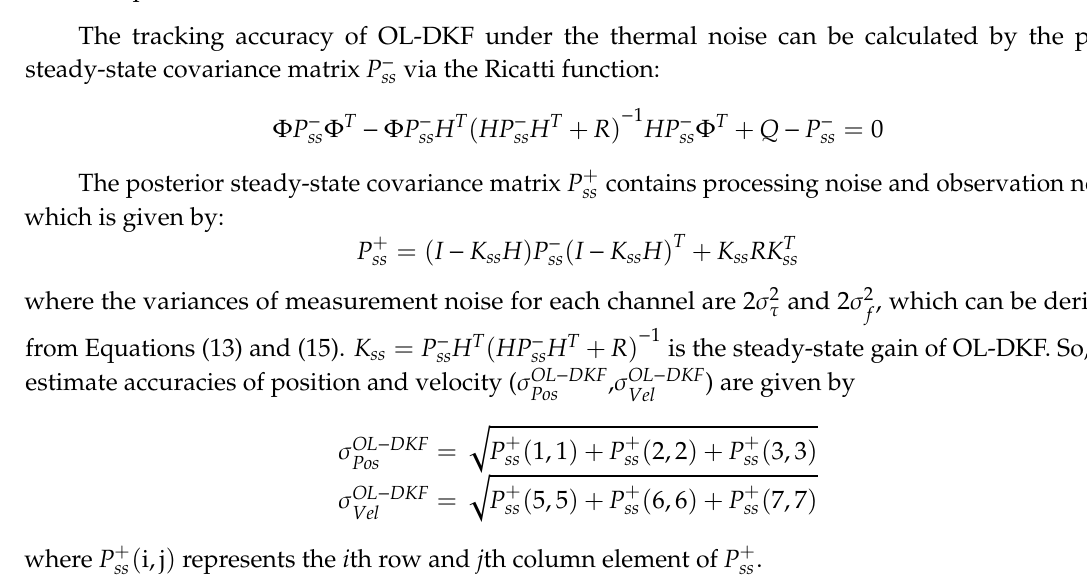
Figure 7. Doppler error curve of the open loop under thermal noise.